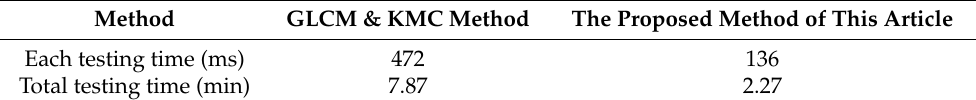
Table 8. The effect of image compression on performance time.